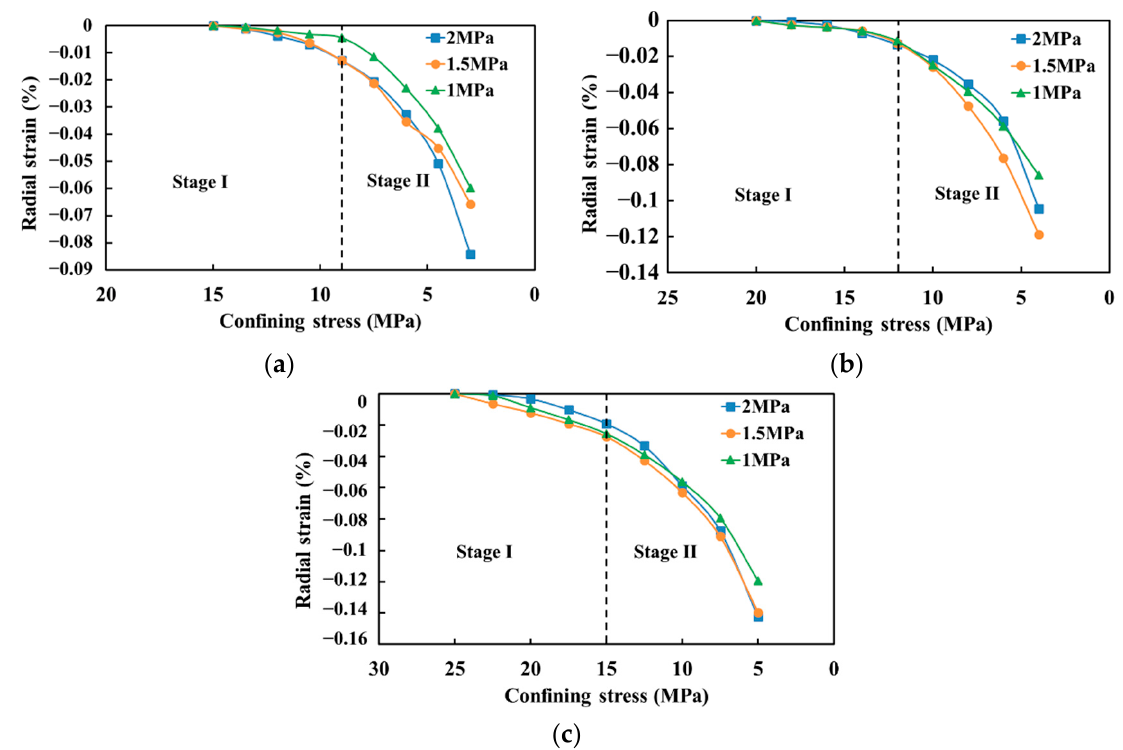
Figure 5. Radial strain variation of sandstone under different initial confining pressures (( a – c ) are the initial confining pressure of 15 MPa, 20 MPa, and 25 MPa,